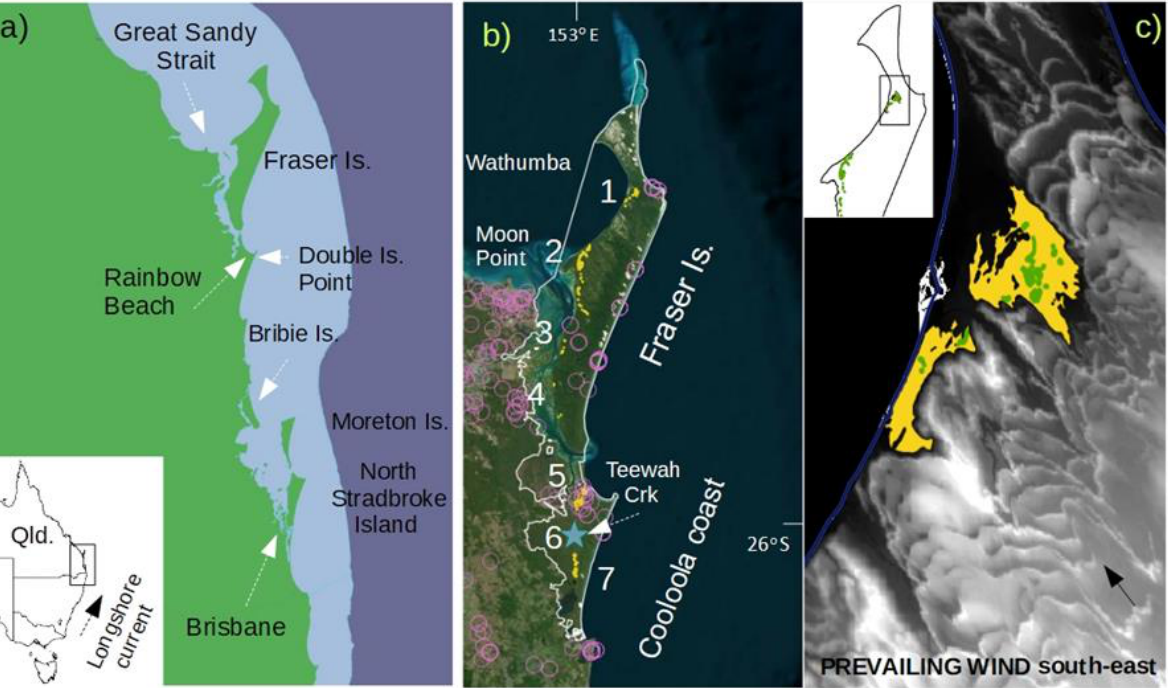
Figure 1. Geographical setting. a) south-east Queensland with features mentioned in text; light blue represents the continental shelf (Geoscience Australia 2009). b) Great Sandy Region showing the proposed Great Sandy World Heritage Area (white outline), patterned fens (yellow, numbered as in Table 1) and registered bore wells (pink circles; Queensland Government 2018). c) Elevation around a fen setting (black = sea level, white = parabolic dune crests to 130 m a.s.l.). The largest area of low drainage contains wet heath (yellow, northern area is 3 km wide) and patterning (green). Elevation data courtesy State of Queensland (Department of Science, Information Technology, Innovation and the Arts)